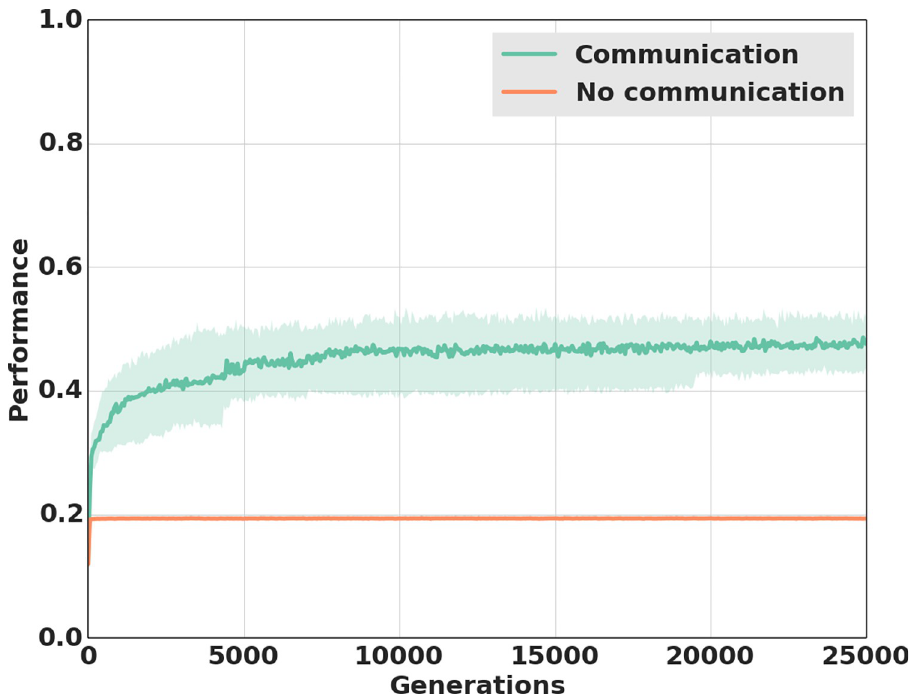
Fig 2. Performance over generations of evolution depending on communication capabilities. Performance (i.e., the proportion of time spent by the receiver on the site containing food) over the 25’000 generations of selection when individuals could freely communicate (green line) and when they were prevented from communicating by setting the signal perceived by the receiver to a constant zero value (orange line). Each experimental treatment was replicated over 40 populations. The colored areas represent the first and third quartiles.